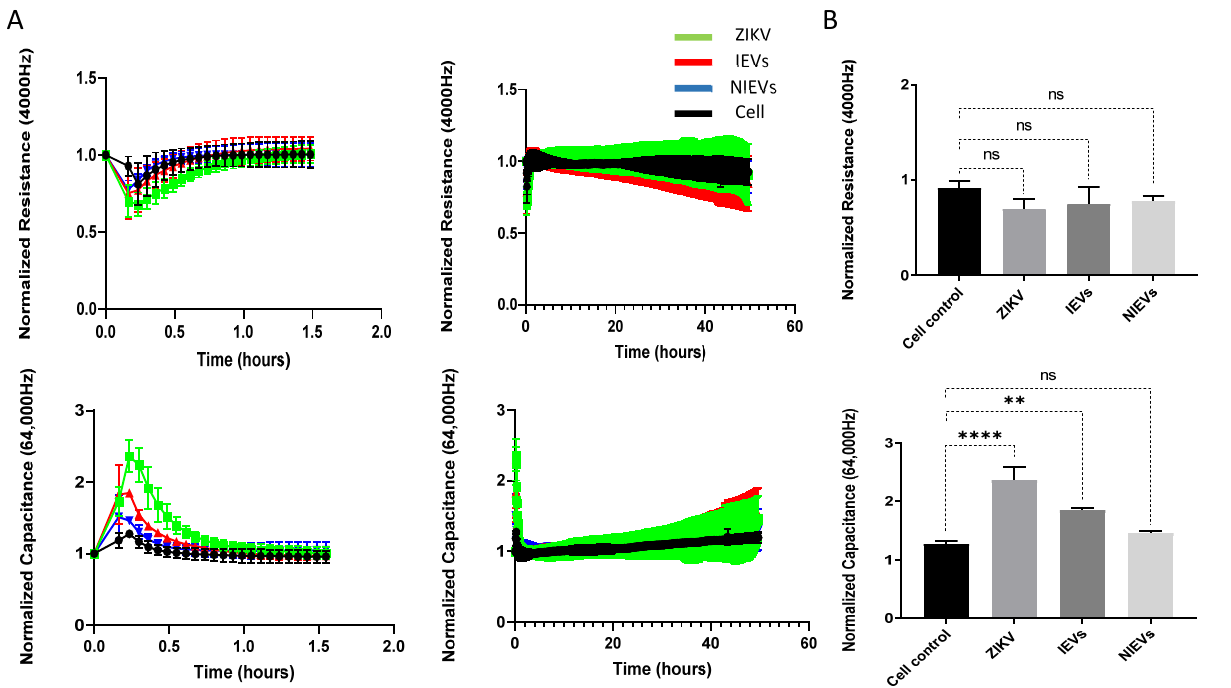
Figure 3. Both ZIKV and IEVs induce temporal disturbances in the monolayer integrity of BBB during the first minutes. ( A ) Normalized resistance (4000 Hz, upper ) and capacitance (64,000 Hz, bottom ) values indicate that ZIKV (green) and IEVs (red) can induce temporal changes in monolayer integrity of hcMEC/D3 cells, which could potentially result in passing via transcellular route within the first 30–45 min ( left panel ). However, no further changes are observed during the later stages (2 days post-infection, right panel ). ( B ) Maximal changes (as compared to cell control, black) in the permeability of BBB during the first minutes demonstrate that ZIKV and IEVs (not NIEVs, blue) significantly alter capacitance ( lower ), but not resistance ( upper ) values. Normalization of the resistance/capacitance values was performed by dividing each data point by the value at the time point prior to sample addition. Data are acquired from three independent experiments. Significance is calculated based on p -values. ns: p > 0.05, * p < 0.05, ** p < 0.005, *** p < 0.0005, **** p <